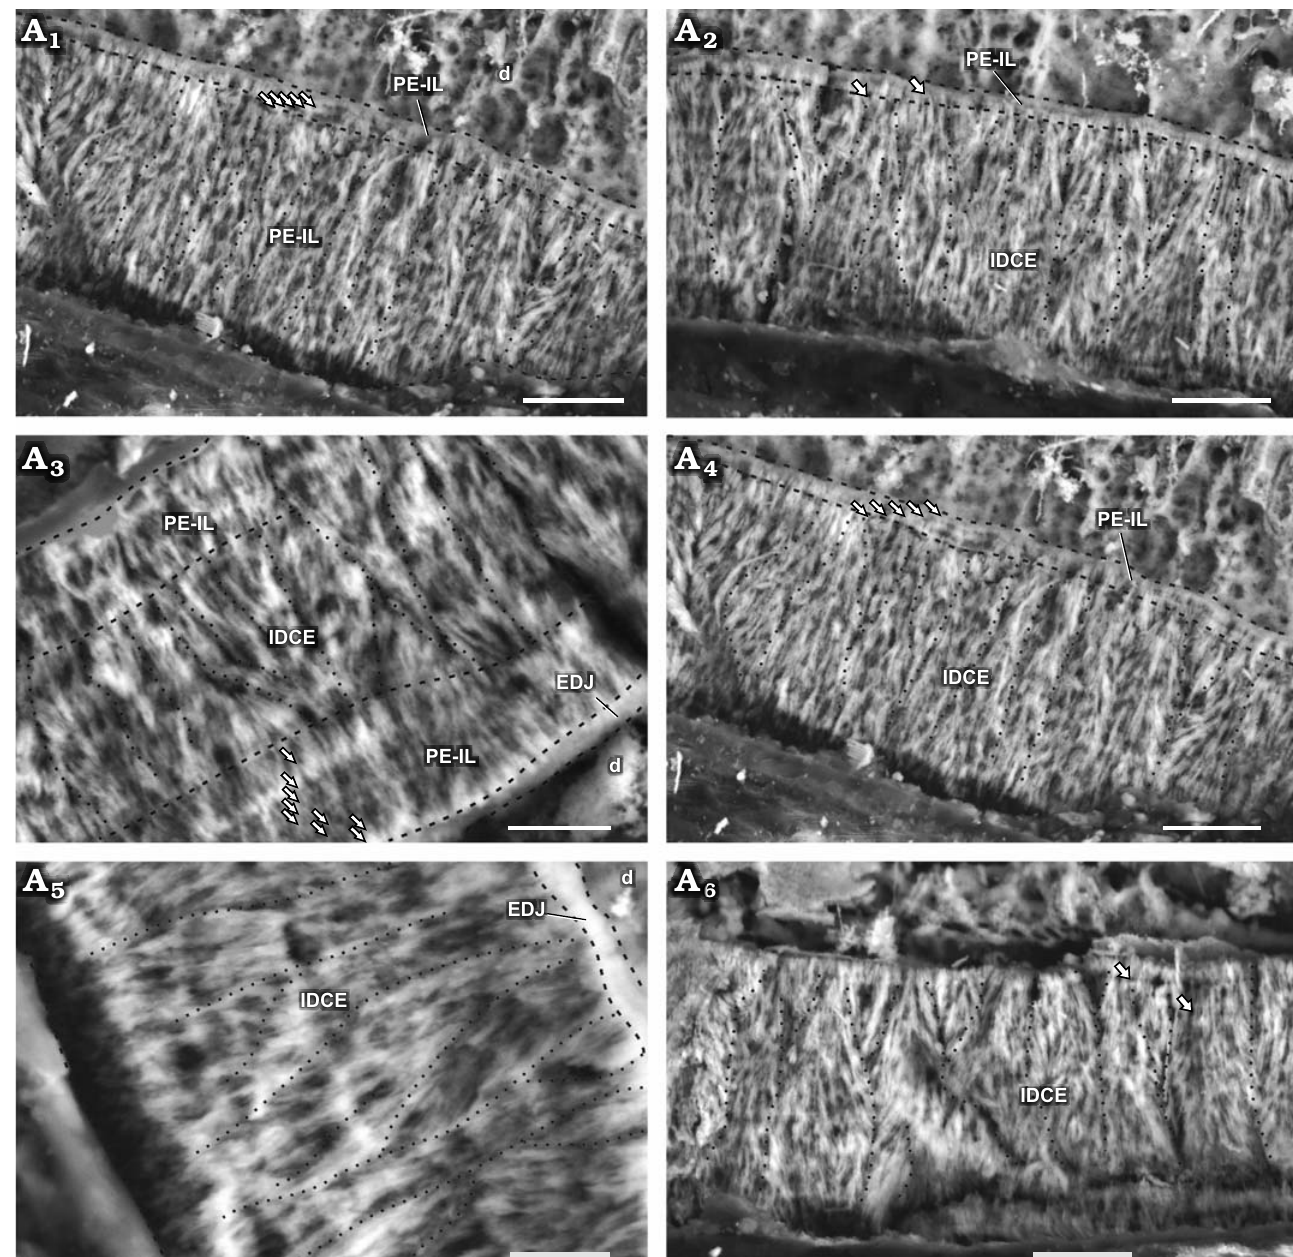
Fig. 3. Enamel in maxillary tooth MPEF-PV 3821 of a basal ornithischian Manidens condorensis Pol, Rauhut, and Becerra, 2011 from Cañadón Asfalto Formation (Queso Rallado locality, late Toarcian), Chubut province, Argentina. Details of the most common enamel in maxillary teeth (A 1 , A 2 , A 4 ), basal PE-IL enamel followed by IDCE up to the EES. Details of different patches comprising a tri-layered enamel (A 3 ) and only IDCE from the EDJ to the EES (A 5 , A 6 ). Arrows point to IL, dot lines separate different IDCU, dashed lines indicate the possible limits of different enamel types and the EDJ. Abbreviations: d, dentine; EDJ, enamel-dentine junction; IDCE, incipient divergent columnar enamel; IDCU, incipient divergent columnar units; IL, in- crementing lines; PE-IL, parallel/divergent crystallite enamel with incrementing lines. Scale bars 10 μ